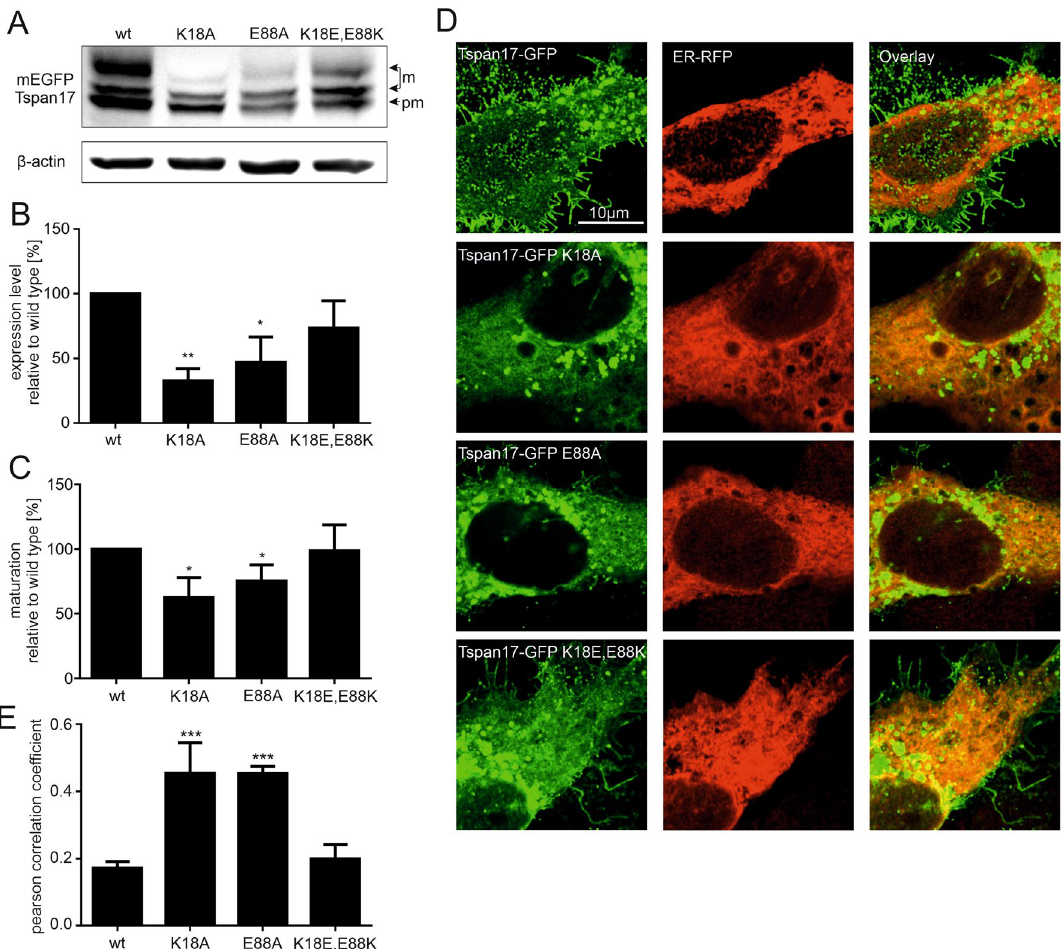
Figure 5. Analysis of the glutamate-lysine interaction . ( A ) In mEGFP-Tspan17, glutamate or lysine were exchanged to alanine (mutants K18A and E88A) or interchanged (K18E/E88K). Constructs are expressed in HepG2 cells, and expression levels are analysed by Western Blot analysis. Maturation of Tspan17 involves N-glycosylation and the different bands representing pre-mature (pm) and matured (m) protein are marked with an arrow (for identification of the bands see Fig. S9). ( B ) The actin normalized GFP signal shows a drop in expression level upon glutamate or lysine mutation (wild type values are set to 100%). The mutation with interchanged charged residues restores the expression level. The drop in Tspan17 expression and maturation is detectable shortly after expression starts (Fig. S10). ( C ) The maturation was calculated as ratio between mature to total protein and was compared to the wild type (set to 100%). The glutamate-/lysine-mutation leads to a drop in protein maturation, whereas the double mutation has no effect. ( D ) The co-localization of the mEGFP- Tspan17 constructs with the ER were analyzed by confocal microscopy, comparing the distribution of the GFP signal to an ER marker fused to RFP. For quantification, the Pearson correlation coefficient between the two channels was calculated. Exemplary images of Tspan17 wt and the mutants are shown. ( E ) The Pearson correlation coefficient showed an increase of ER co-localization for the glutamate-/lysine-mutants and no effect of the double mutation. Values are given as means ± SD (n = 4 for Western blot analysis and n = 3 for microscopy; for each biological replicate 10 cells were imaged). The statistical analysis was done employing a repeated measures ANOVA comparing each mutation with the wild type. The full blots are shown in the supplementary data (Fig. S20). The data analysis and illustration was performed using Fiji-ImageJ 34 (https:// imagej. net/) and GraphPad Prism version 6.04 for Windows (www. graph pad. com), expression and glycosylation and causes ER retention. Next, we exchanged the positions of glutamate and lysine, which may neutralize the effect of the single mutations as the putative electrostatic interaction may work as well with exchanged positions of the charges. As shown in Fig. 5, all effects are back to normal in the double mutant. The same mutations in other tetraspanins, e.g. CD9, yield the same expression pattern as for Tspan17 (Fig. S11A) but no effect on ER-exit (Fig. S12). Because in our assay we detect no change in the CD9 band pattern after tunicamycin treatment (Fig. S9), we did not employ maturation analysis of CD9 via probing its glycosylation status. Instead, we examined whether the interaction with the primary binding partner EWI-2 is affected. As shown in Fig. S13, single mutations precipitated more EWI-2 than the wild-type or the double